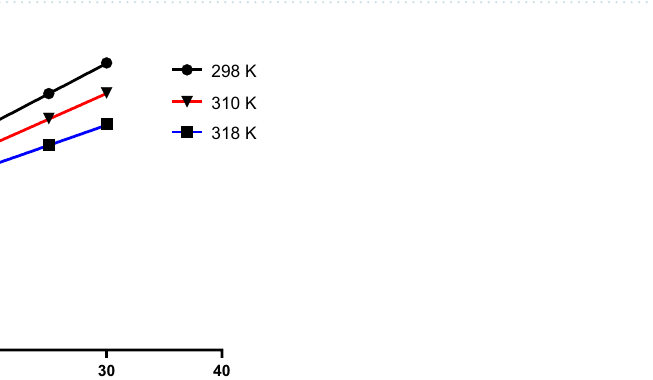
Figure 3. ( A ) Fluorescence spectra of BSA (40 µM) in presence of MBZ (4, 5, 10, 15, 20, 25, 30, 35, 40, 45 µM) at 298 K and pH 7.4. ( B ) Excitation (red curve) and emission (green curve) spectra for BSA 40 μM at 298 K and pH 7.4. (λ em ) = 338 nm and (λ ex ) = 285 nm. ( C ) 3D fluorescence spectra of BSA (40 µM) in presence of MBZ (4, 5, 10, 15, 20, 25, 30, 35, 40, 45 µM) at 298 K and pH 7.4.